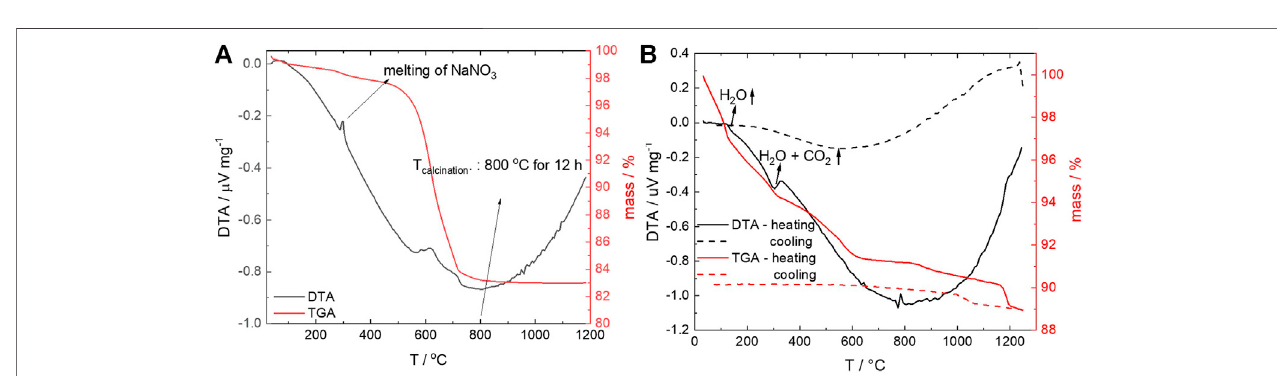
FIGURE 2 | DTA/TG analysis of NNFM pre-calcined at 500 ° C for 10 h in air (A) and of mixed NNFM/NZSiP (B) . Measurements performed in arti fi cial air with a heating and cooling rate of 5 K/min.